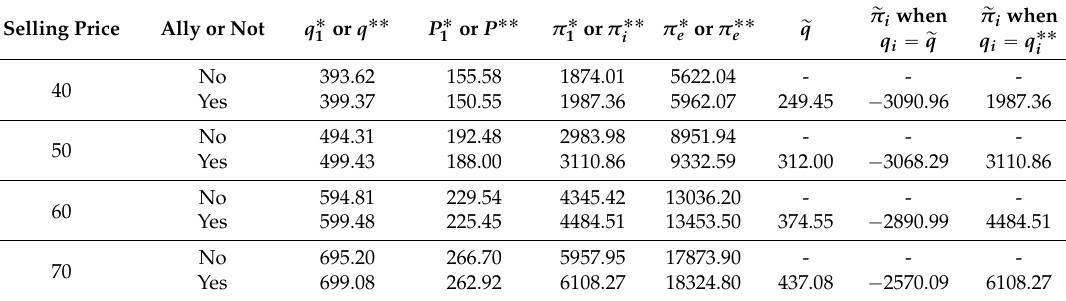
Table 2. The optimal cooperation policies of different selling prices when C e “ 80